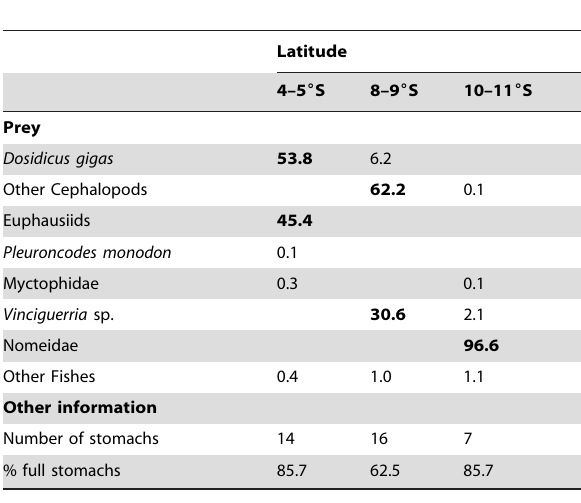
Table 3. Diet (% by mass) of large jumbo squids (65–85 cm ML) collected off Peru (4–11 u S) during